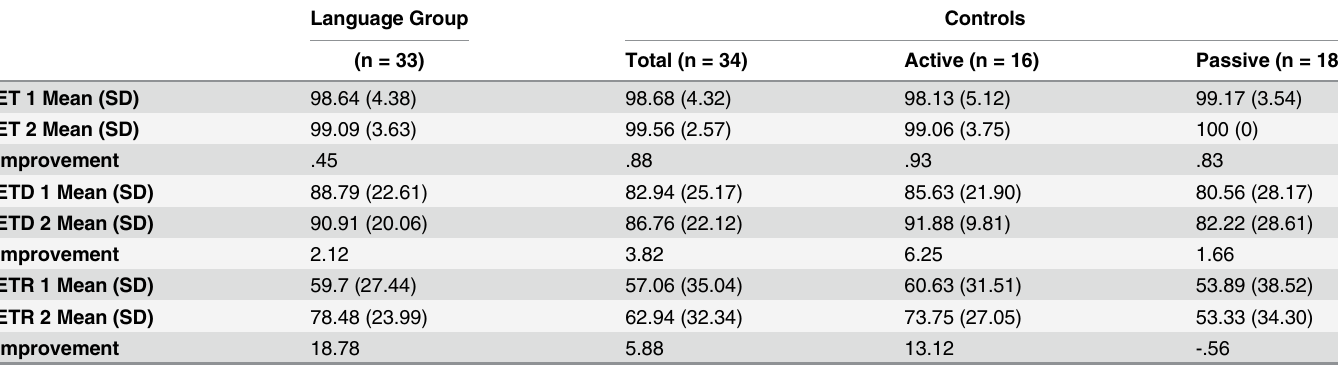
Table 1. Summary of group performance on the Test of Everyday Attention